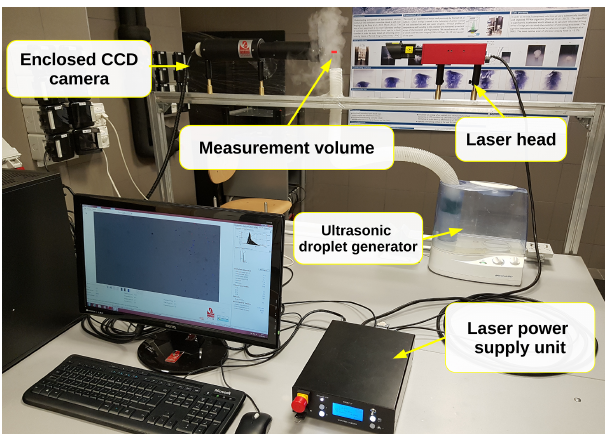
Figure 1. Experimental setup for studying the detection properties (see Sect. 3 for details). The main parts of the VisiSize D30 are an infrared pulse laser with a diffuser (top right) and a CCD camera with the lens objective enclosed in a waterproof housing (top left). Water droplets produced with an ultrasonic droplet generator are measured while passing through the sample volume (top middle) located close to the